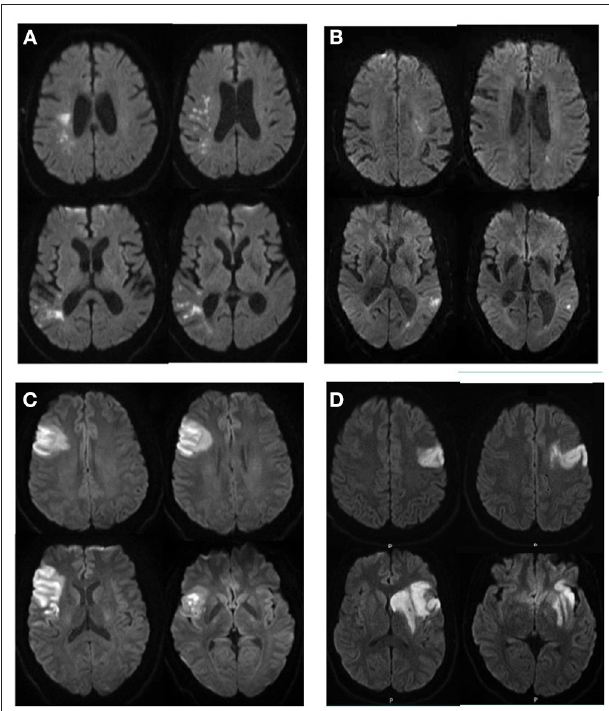
FIGURE 2 | Illustrative cases of patients with right (A,C) and left (B,D) strokes, with similar NIHSS and very different infarct volumes (A,B) ; or similar infarct volumes and very different NIHSS (C,D) . (A) 76 year-old man, NIHSS = 4, infarct volume of 11.9 cc; (B) 84 year-old man, NIHSS = 5, infarct volume of 2.2 cc; (C) 34 year-old man, NIHSS = 6, infarct volume of 39 cc; (D) 35 year-old man, NIHSS=10, infarct volume of 38 cc.